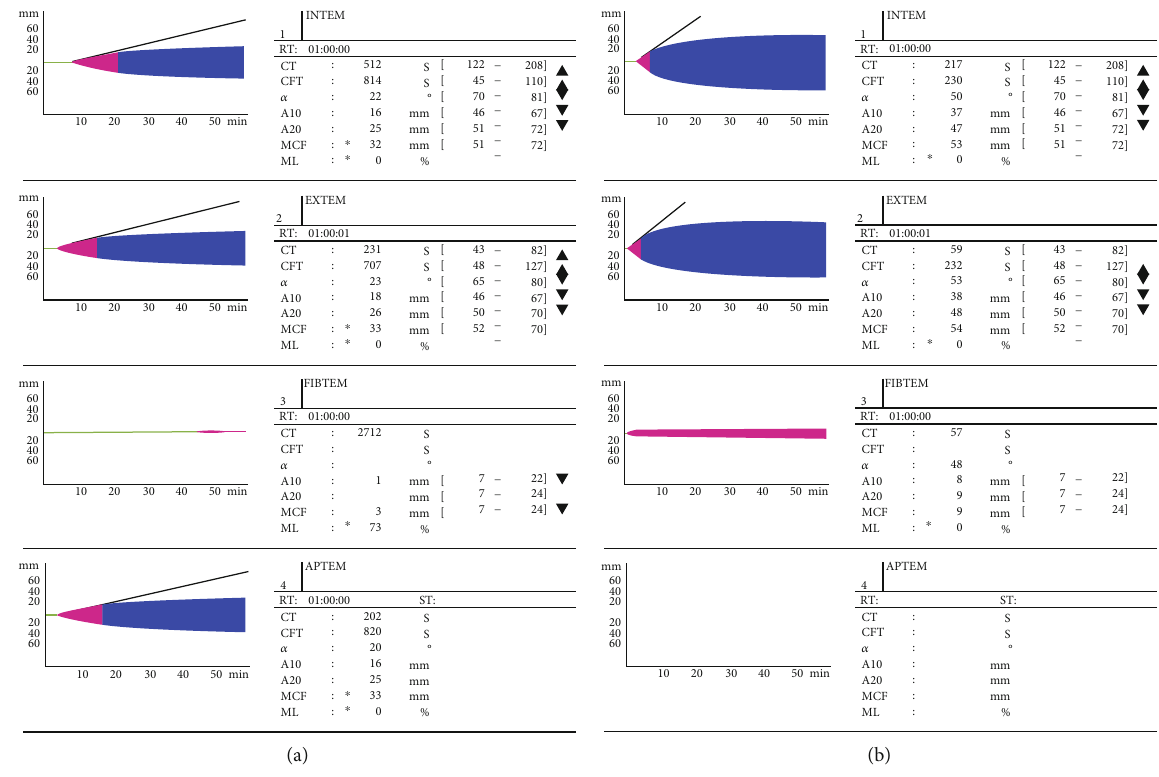
Figure 1: Initial and subsequent rotational thromboelastometry (ROTEM) parameters for a patient with amniotic fl uid embolism. (a) ROTEM obtained just after ECMO initiation demonstrates extremely prolonged clotting time, poor clot amplitude, and fi brinolysis. (b) ROTEM obtained after additional FFP and cryoprecipitate showing dramatic improvement with normal EXTEM clotting time, mildly prolonged INTEM clotting time, normal FIBTEM clot amplitude, and EXTEM/INTEM clot amplitude just below the normal